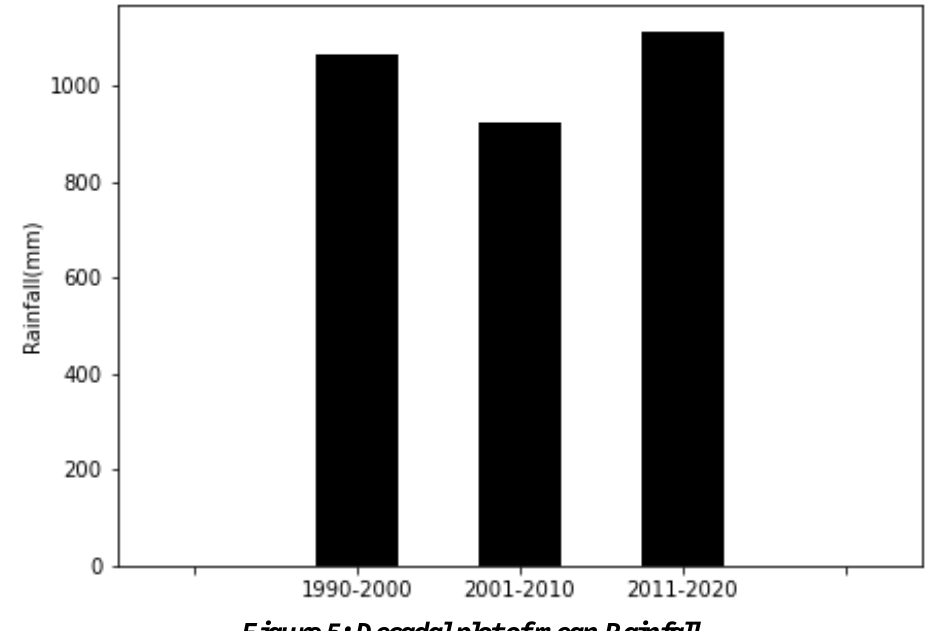
Figure 5: Decadal plot of mean Rainfall.